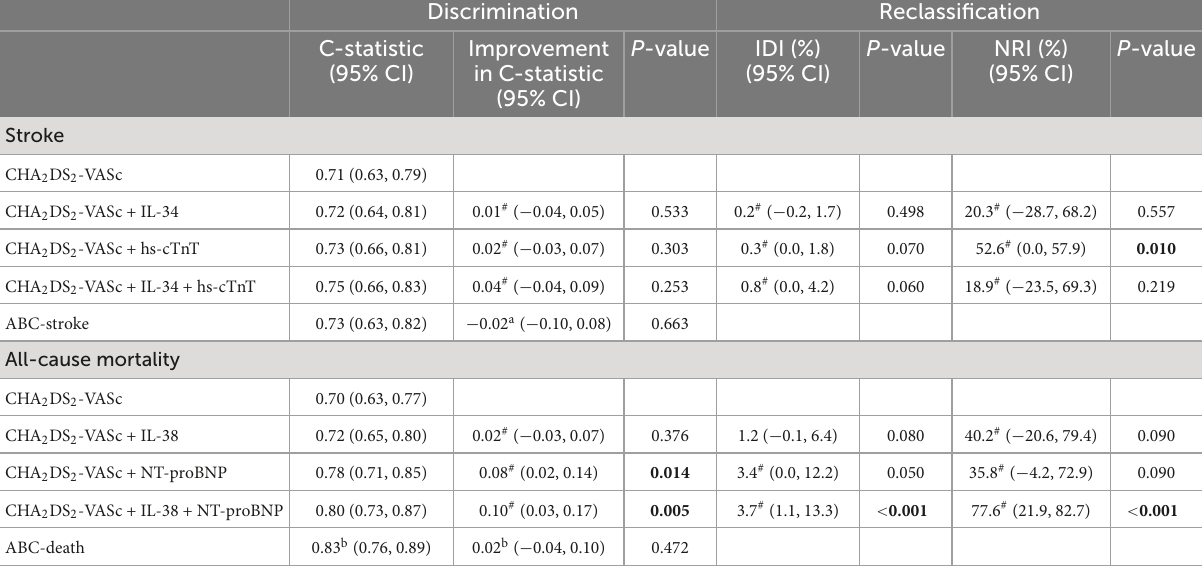
TABLE 3 Discrimination and reclassification for stroke, all-cause mortality, or cardiovascular death.